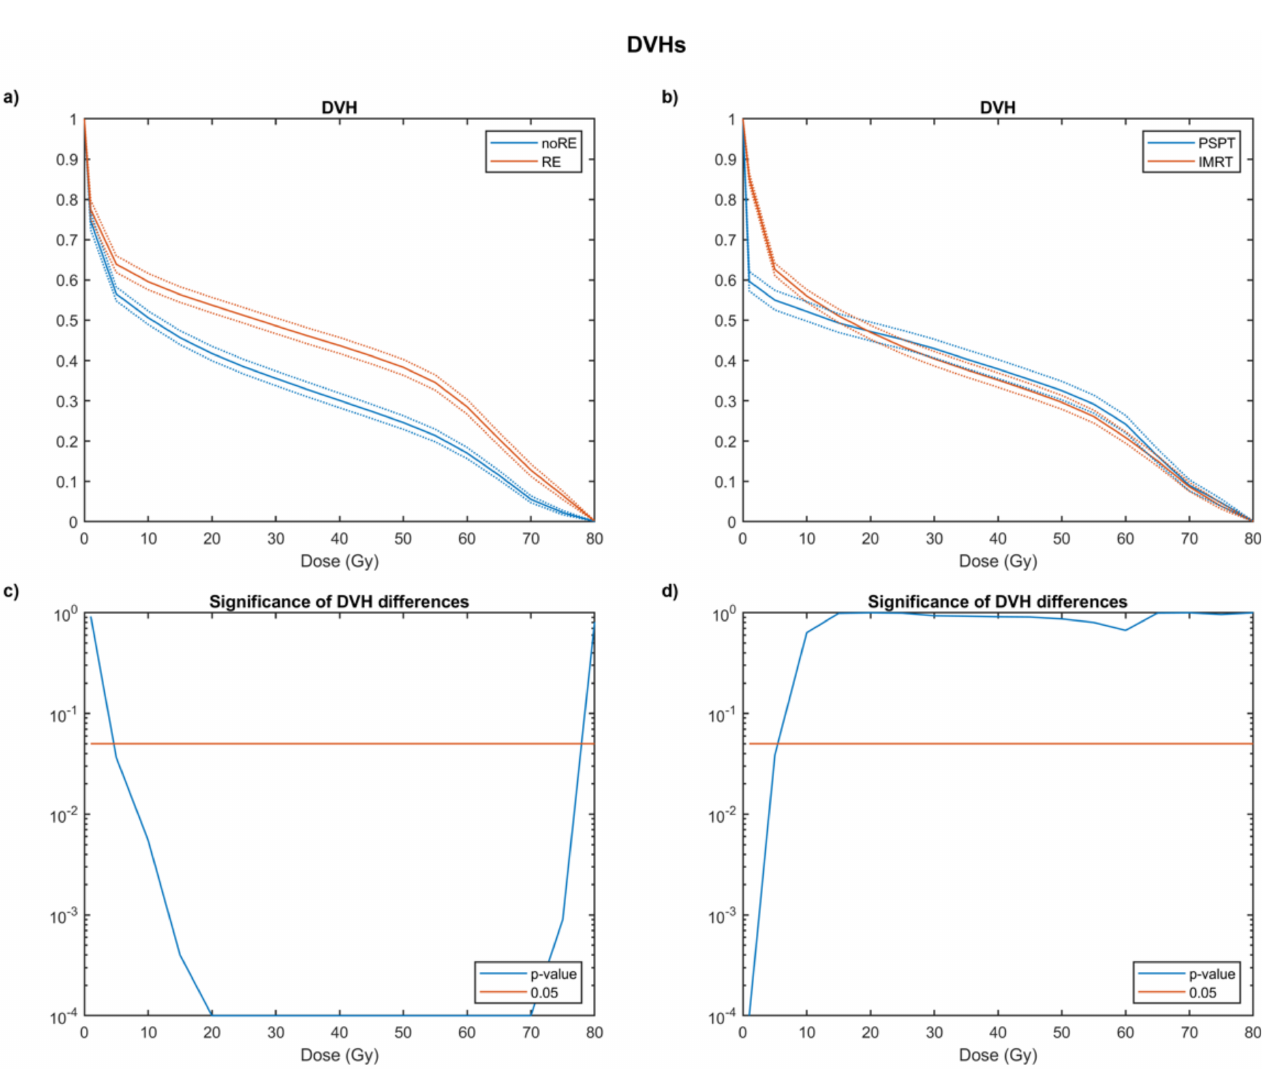
Figure 1. Average esophageal dose volume histograms (DVHs) ± SEM (standard error of the mean) in patients who developed radiation-induced esophagitis (RE) of grade ≥ 2 and not ( a ); average esophageal DVHs ± SEM (standard error of the mean) in patients treated with Intensity Modulated Radiation Therapy (IMRT) and Passive Scattering Proton Therapy (PSPT) ( b ). The SEM is plotted as dashed lines. Semi-logarithmic plot of the observed significance level estimated by a non-parametric maximum- T permutation test between DVH values for RE and unaffected patients ( c ); semi-logarithmic plot of the observed significance level estimated by a non-parametric maximum- T permutation test between DVH values for IMRT and PSPT ( d